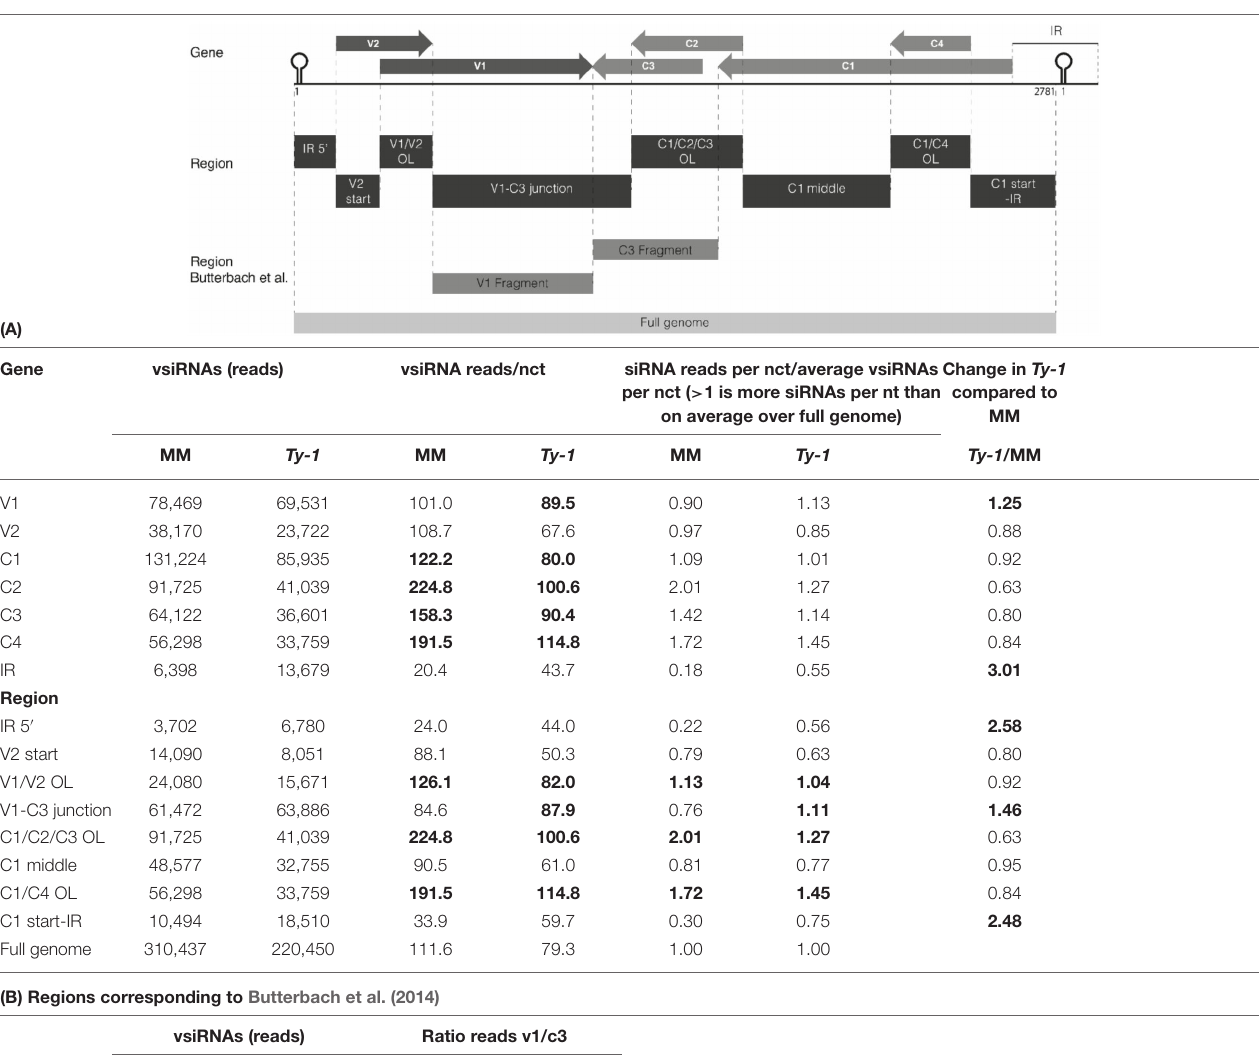
TABLE 2 | Distribution of vsiRNAs on the TYLCV